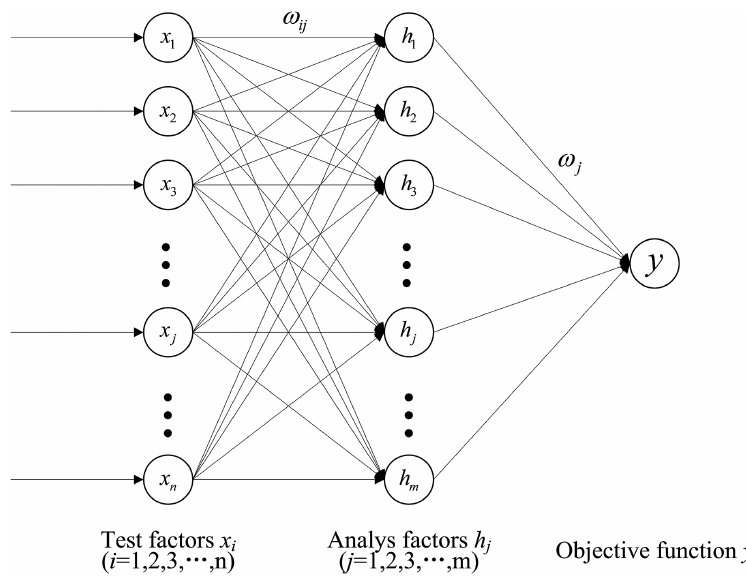
Figure 4: Relationship between the flow stress and influence